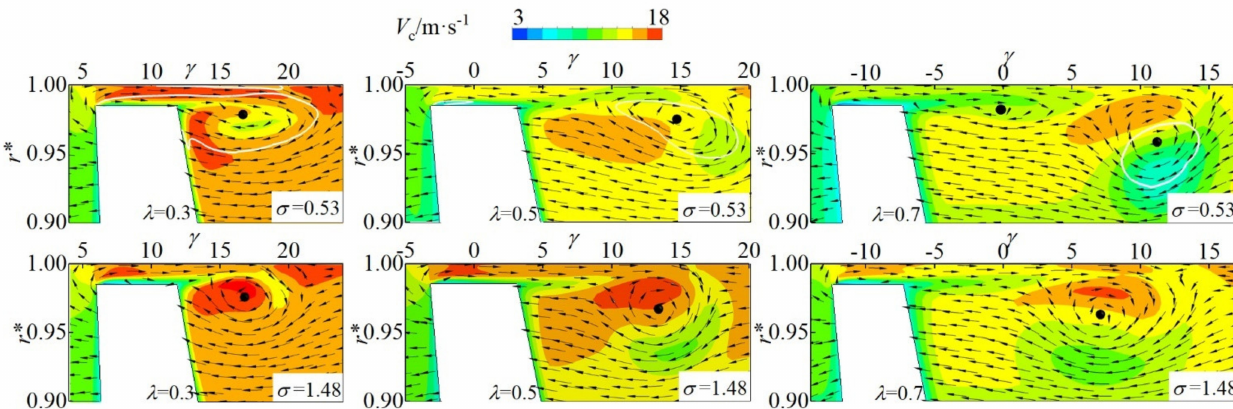
Figure 15. Comparison of circumferential velocity V c distribution on the three planes for the cavitating case ( upper ) and non-cavitating case ( lower ) (the solid point is the vortex center, and white line represents the isovalue of the vapor volume fraction ( α v =